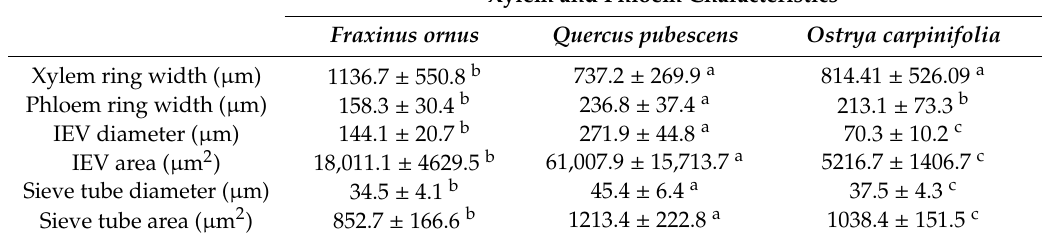
Table 3. Xylem and phloem ring widths and anatomical characteristics of initial earlywood vessels (IEVs) and sieve tubes (mean ± standard deviation). Characteristics marked with the same letters are not significantly di ff erent ( α ≤